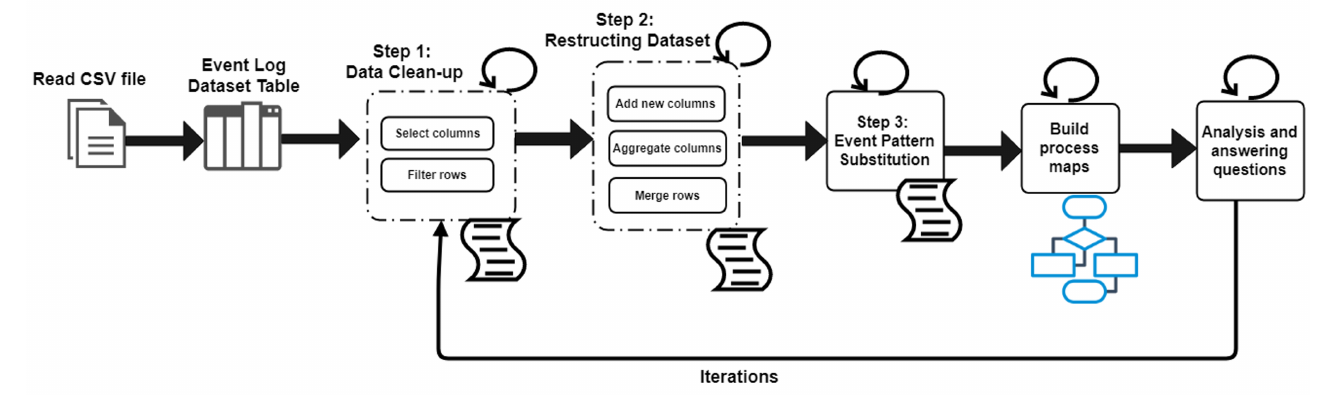
Figure 2. Overview of the CPA-PM method and its three main iterative